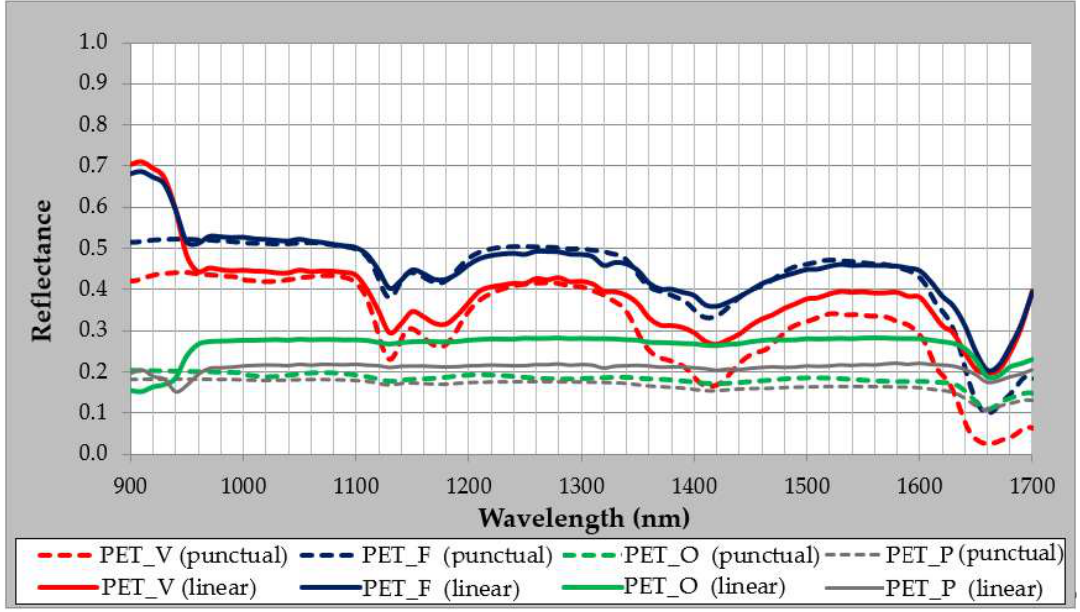
Figure 2. Spectral signatures of PET samples in the NIR region detected with the linear spectrometer (data referred to as ‘linear’ in the plot) and with the spectroradiometer (data referred to as ‘punctual’ in the